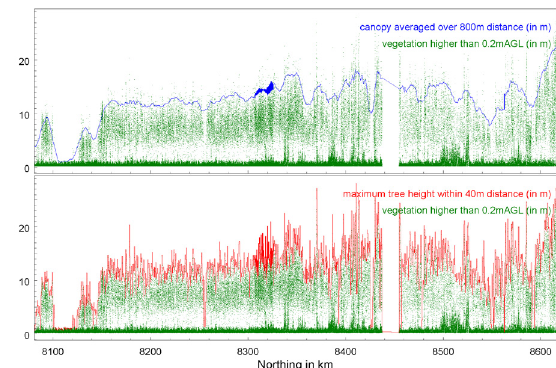
Figure 5: Canopy structure measured along the NATT using the lidar flown in the ARA-DIMO. Green: Vegetation higher than 20cm AGL; blue: Tree Canopy averaged over 800m; red: Maximum tree height within 40m dis- tance (along track).